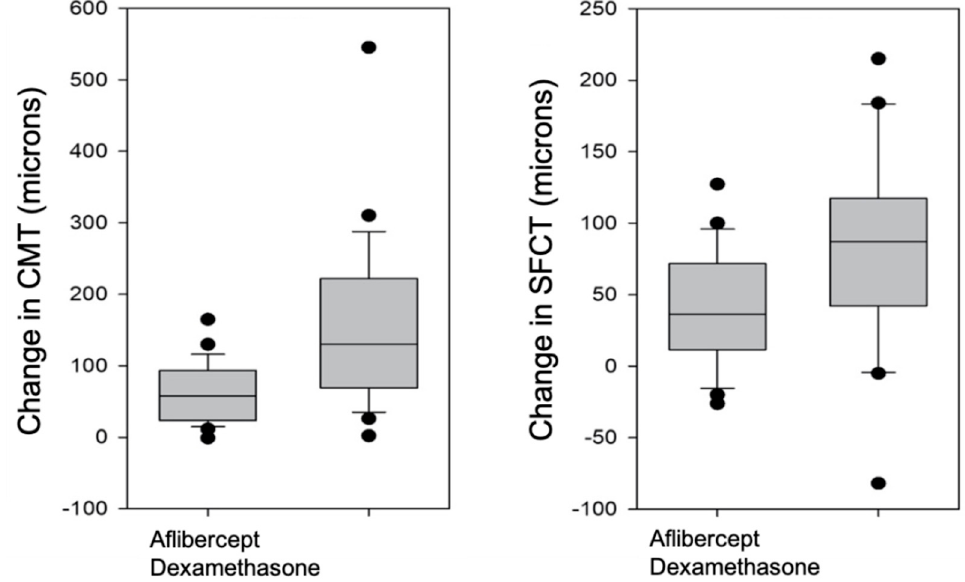
Figure 4. Change in central macular thickness (CMT) (left) and subfoveal choroidal thickness (SFCT) (right) after intravitreal therapy with aflibercept or dexamethasone.